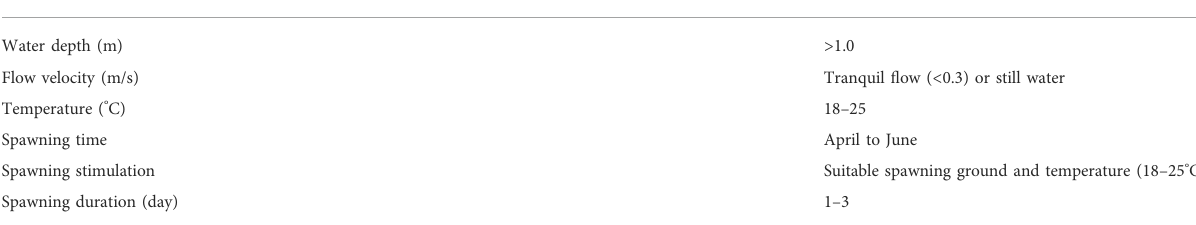
TABLE 1 Requirements for spawning habitat of Yellow River